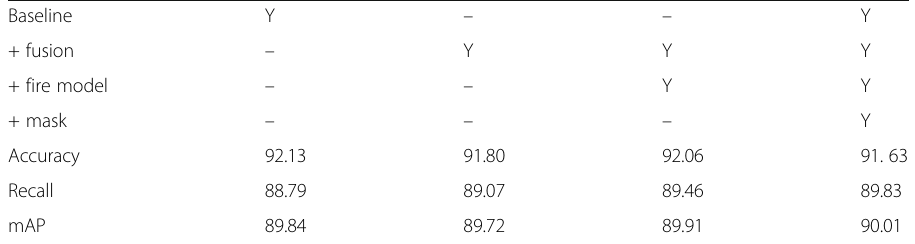
Table 1 Results of ablation experiments of various components